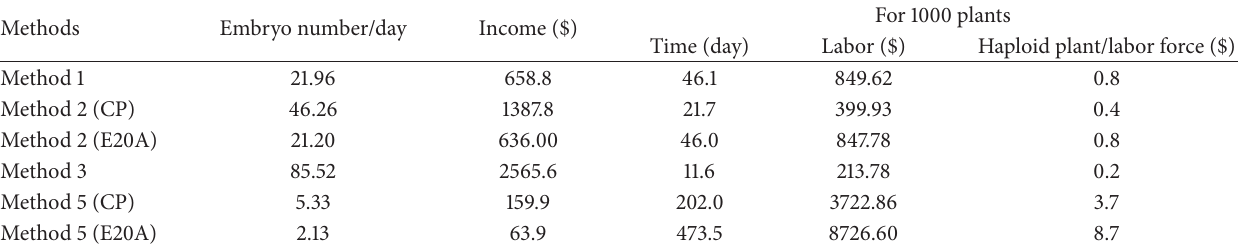
Table 4: Labor force and embryo costs according to time in different embryo rescue